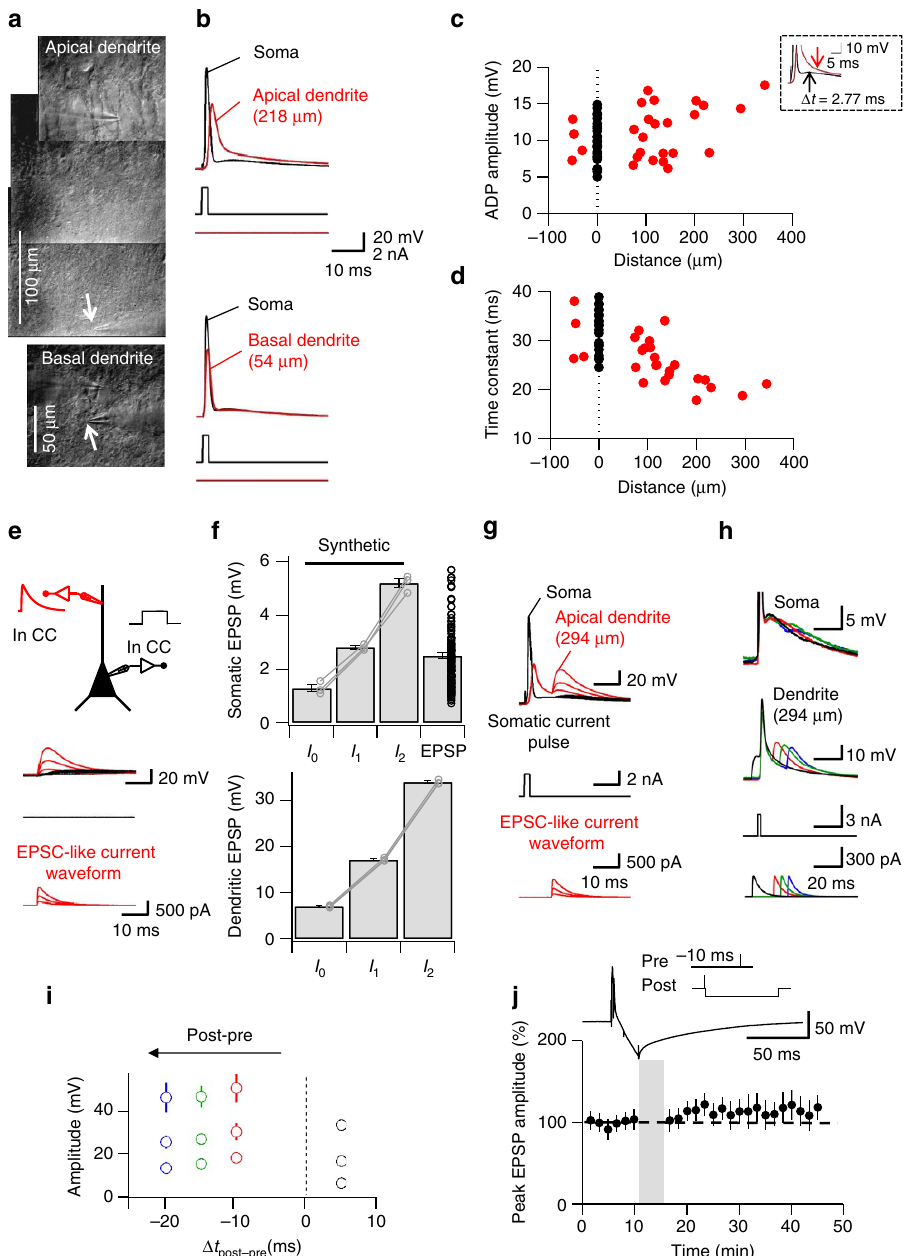
Figure 3 | Dendritic afterdepolarization may represent the associative signal for LTP induction during post–presynaptic pairing. ( a ) Dendritic recording from apical (top) and basal CA3 pyramidal neuron dendrites (bottom). Infrared-DIC videomicrographs (photomontage for top graph) taken under experimental conditions. Arrows indicate dendritic recording sites. ( b ) The ADP has comparable amplitude at soma and dendrite. Dendritic recording sites 218 m m (top) and 54 m m (bottom) from the soma. Somatic (black) and dendritic AP (red), evoked by somatic current injection. ( c ) ADP amplitude remains constant as a function of distance from soma. Positive and negative distance values represent apical and basal recordings, respectively. Black, somatic ADP; red, dendritic ADP. Inset shows procedure to measure the ADP in the dendrite (at 294 m m). Note that the ADP amplitude shows a slight, but insignificant increase as a function of distance (26 simultaneous dendritic-somatic recordings, Spearman rank correlation coefficient r ¼ 0.26; P ¼ 0.065). ( d ) Similar plot as shown in c , but for ADP decay time constant. Note that the ADP becomes faster with increasing distance ( r ¼ 0.72; P o 0.001). ( e ) Properties of synthetic EPSPs, evoked by dendritic current injection. Top, schematic illustration of the recording configuration. Bottom, dendritic EPSPs (red) and somatic EPSPs (black). ( f ) Summary bar graph of peak amplitudes of synthetic EPSPs at the soma (top) and the dendrite (bottom). I 0 , I 1 and I 2 correspond to peak current amplitudes of 123, 306 and 610pA, respectively (three simultaneous dendritic-somatic recordings). Right bar, top shows peak amplitudes of EPSPs evoked by extracellular stimulation (163 cells). ( g ) Summation of synthetic EPSPs with preceding ADPs. APs were evoked by somatic current injection, and synthetic EPSPs were generated by dendritic current injection (amplitudes I 0 , I 1 and I 2 ; D t ¼ (cid:2) 10ms). ( h ) Similar traces as shown in g , but for dendritic current injection amplitude I 1 and D t ¼ 5ms (black), –10ms (red), –15ms (green) and –20ms (blue). ( i ) Plot of peak amplitude of the summated signal in the dendrite against AP–EPSP pairing interval D t (3 simultaneous dendritic-somatic recordings). ( j ) Conversion of the ADP into an afterhyperpolarization during a post–presynaptic sequence abolishes LTP. Top, post–presynaptic pairing protocol ( D t ¼ –10ms) combined with hyperpolarizing somatic current injection and corresponding membrane potential trace. Bottom, plot of mean compound EPSP peak amplitude against experimental time before and after post–presynaptic pairing ( D t ¼ (cid:2) 10ms) with afterhyperpolarization (9